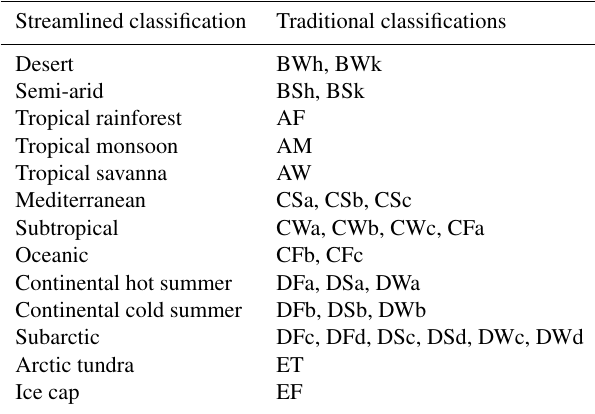
Table 2. Breakdown of the streamlined classification scheme and the assignment of traditional classifications within the new